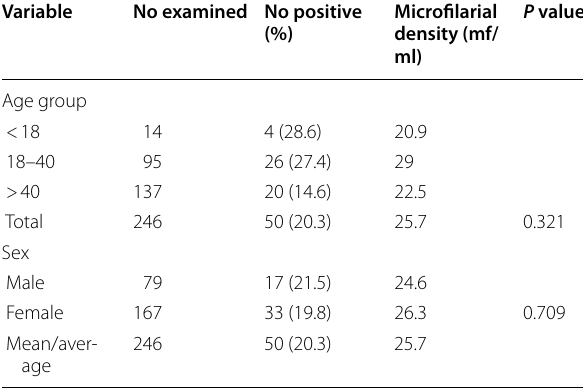
Table 5 Microfilaria intensity of participants in Imobi, Ijebu East Local Government Area